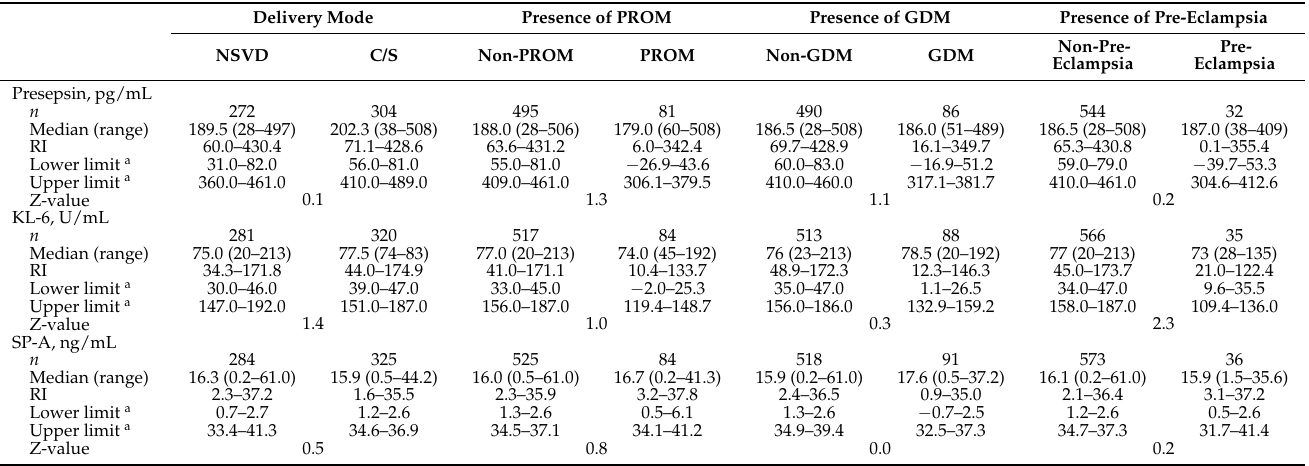
Table 3. Reference intervals of the total group for presepsin, KL-6, and SP-A according to maternal factors.